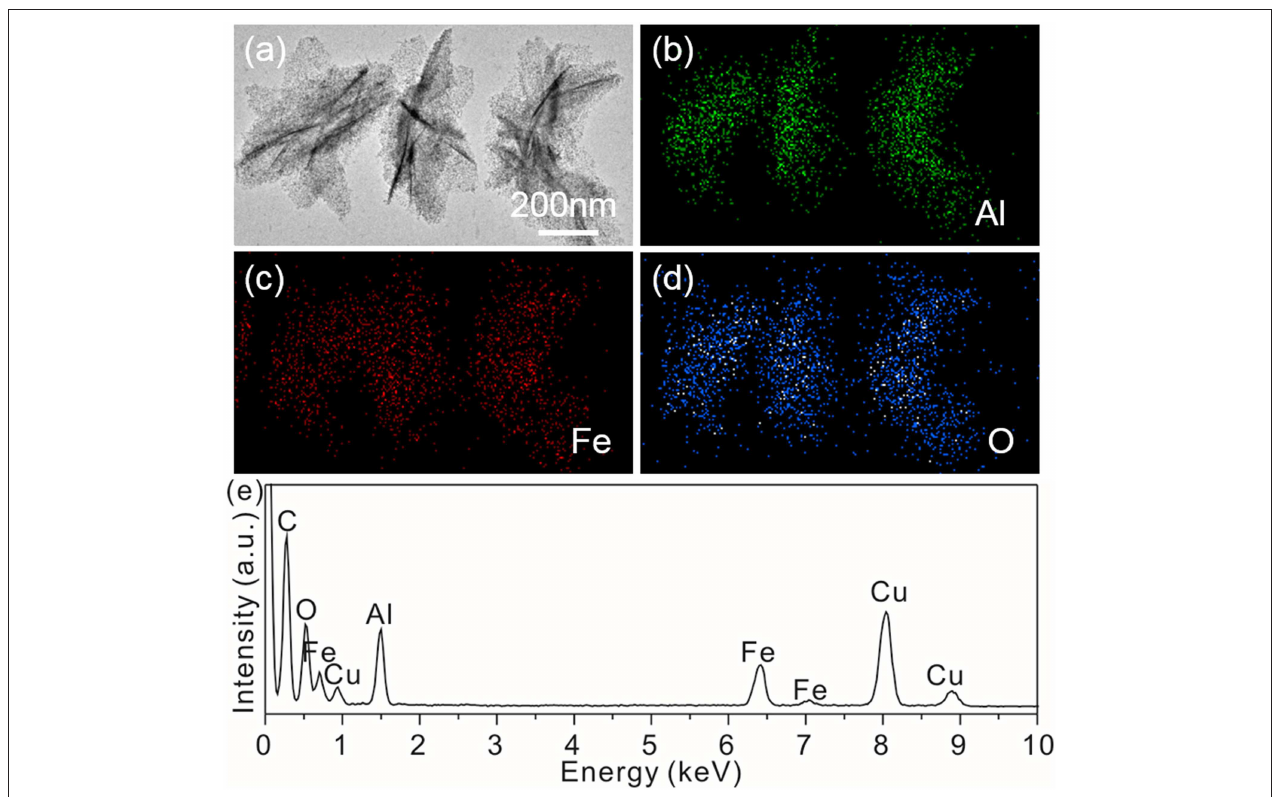
FIGURE 4 | (a) SEM image; Electron energy loss: (b) Al, (c) Fe and (d) O elemental mapping images, (e) EDS spectrum of the γ -AlOOH/Fe(OH) 3